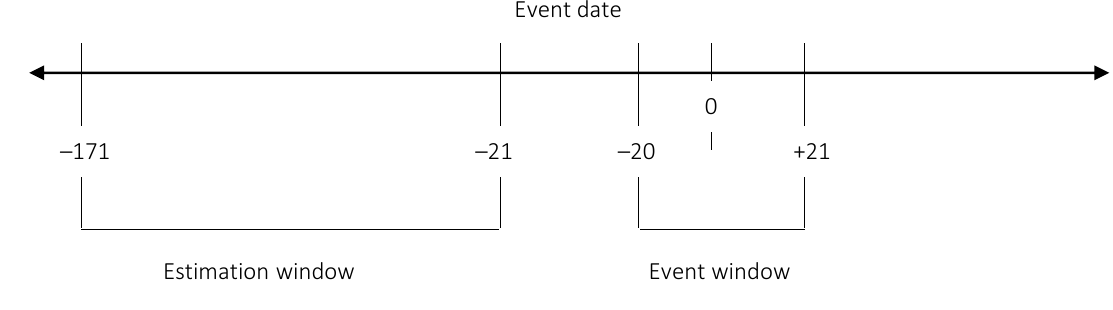
Figure 1. Event study timeline (in